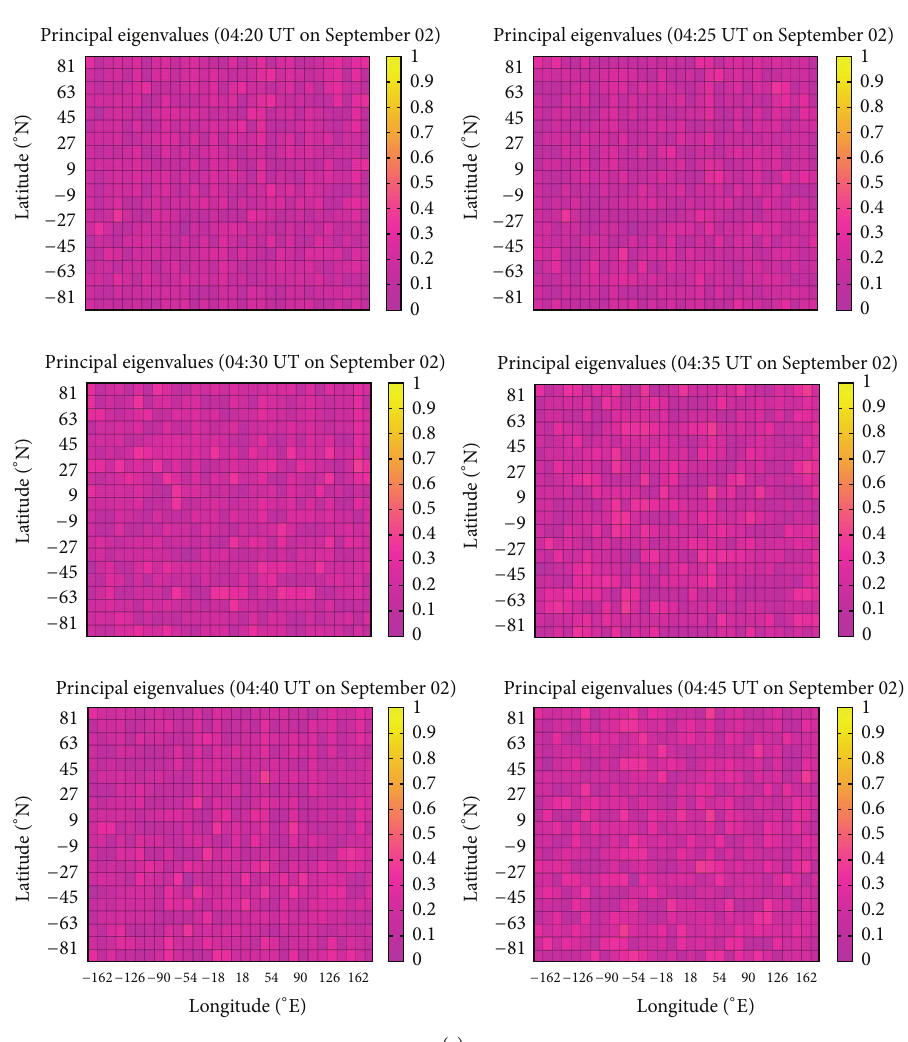
Figure 4: (a) The figures show the GIMs at the time 04:20 to 04:45 on 02 September 2012 (UT). (b) The figures give a color-coded scale of the magnitudes of principal eigenvalues of 2DPCA corresponding to Figure 4(a). (c) The figures give a color-coded scale of the magnitudes of principal eigenvalues of PCA corresponding to Figure